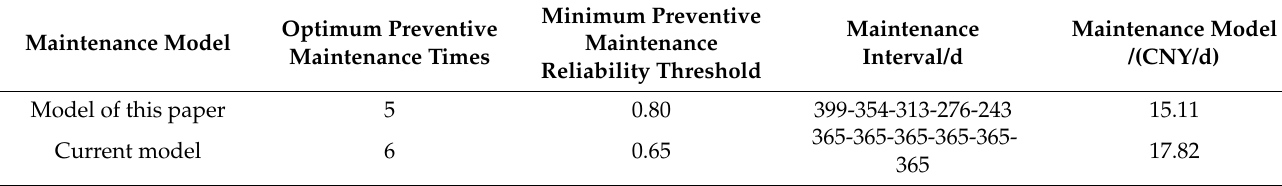
Table 3. Comparison results of maintenance models for the power supply module.